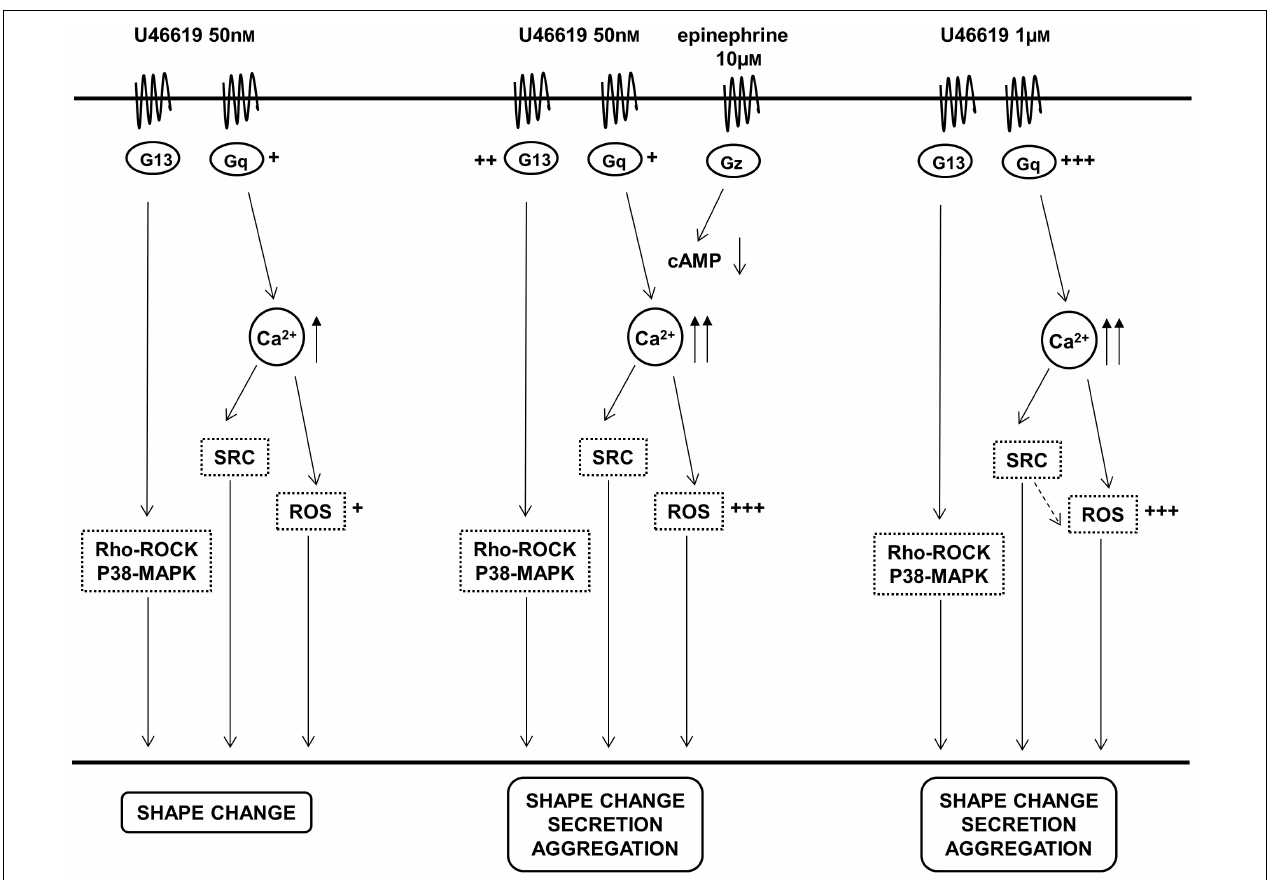
FIGURE 7 | Graphs summarize the relationships between TP receptor activation, signaling pathways and functional responses in platelets stimulated with different amounts of the TXA 2 analog U46619 and the cooperative effects of epinephrine. + , ++ , +++ Represent differences in the implication of the signaling pathways.